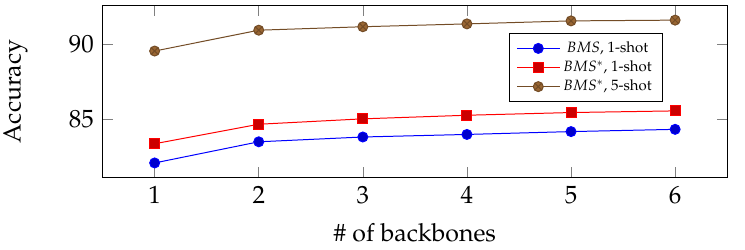
Figure 7. Accuracy of the proposed method in different settings as a function of the number of backbones (dataset: